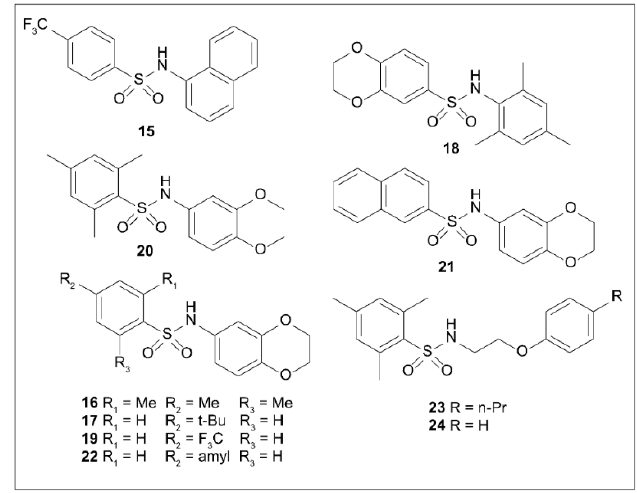
Figure 6. Structures of arylsulfonamides.